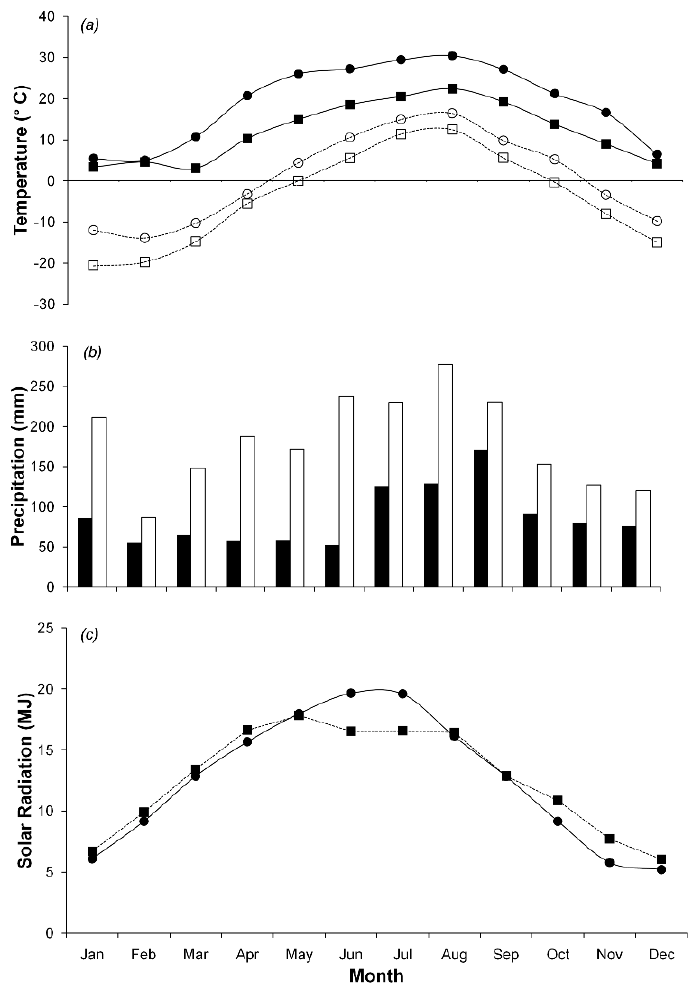
Figure 1. Average monthly meteorological data from 2001–2006 as (a) temperature in terms of minimum temperature at Hitsujigaoka (open rectangular and dashed line) and Takayama (open circle and dashed line), and maximum temperature at Hitsujigaoka (solid rectangular and solid line) and Takayama (solid circle and solid line); (b) precipitation at Hitsujigaoka (solid bar) and Takayama (open bar); and (c) solar radiation at Hitsujigaoka (solid rectangular and dashed line) and Takayama (solid circle and solid